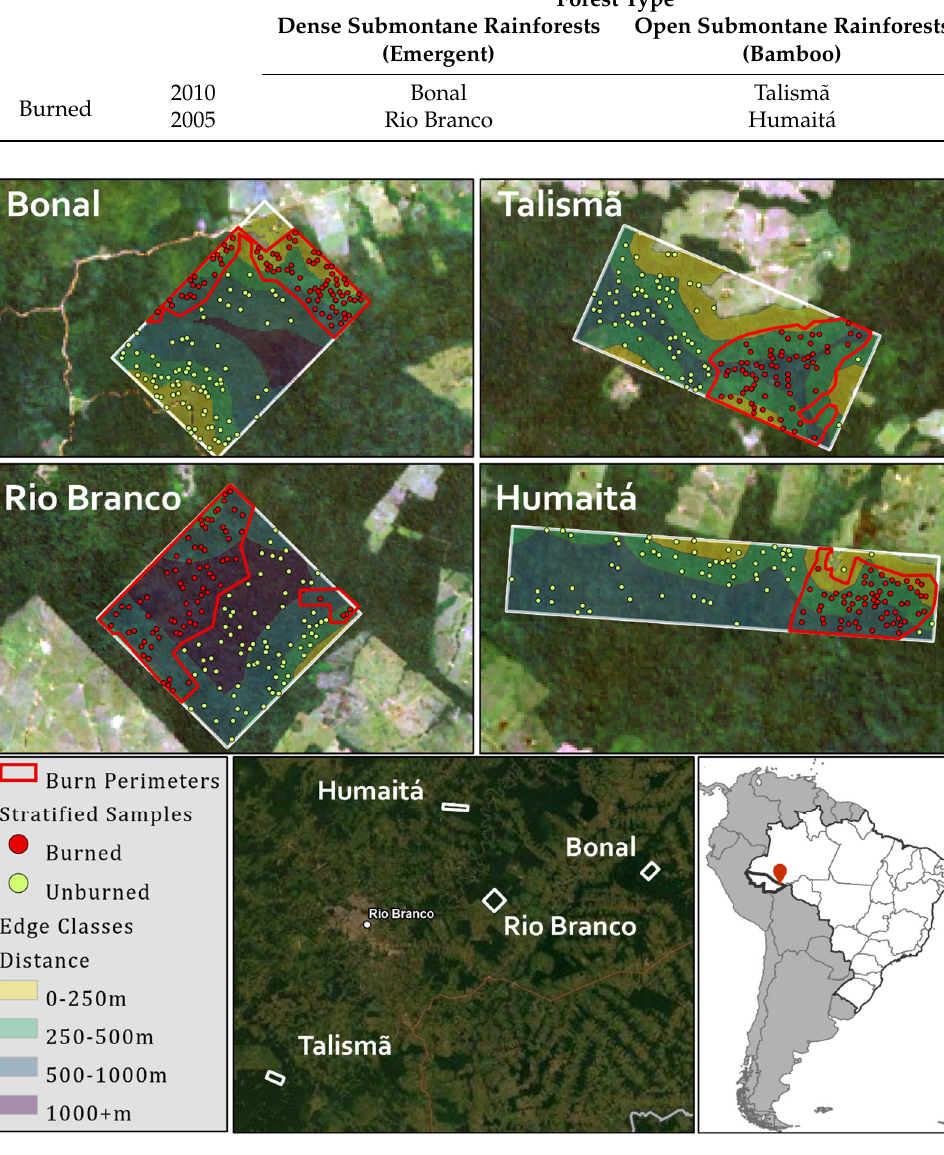
Figure 2. Study area and individual sites with distance from edge classifications with stratified random samples overlayed by burn class (red being burned, green being unburned) within burn parameters.